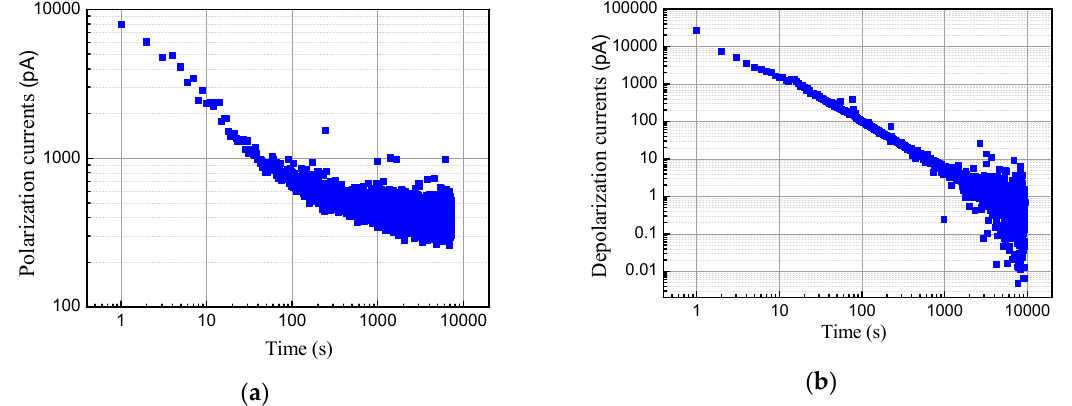
Figure 2. The test results of 20% SiC/PE composite under electric field strength of 30 kV/mm. ( a ) The test results of the polarization currents; and ( b ) the test results of depolarization currents.